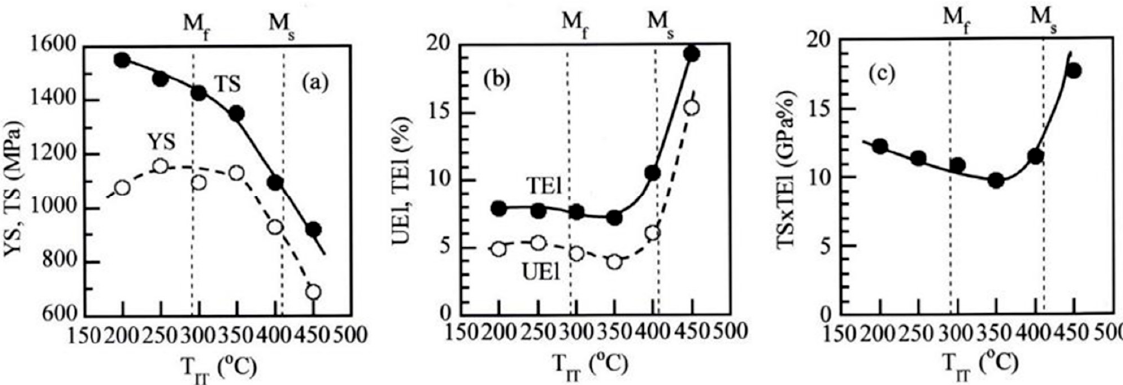
Figure 9. Variations in ( a ) yield stress (YS), tensile strength (TS), ( b ) uniform elongation (UEl), and total elongation (TEl); ( c ) product of TS and TEl (TS × TEl) as a function of isothermal transformation temperature ( T IT ) in 0.20C-1.50Si-1.50Mn-0.05Nb TBF and TM steels. This figure is reproduced based on reference [51].